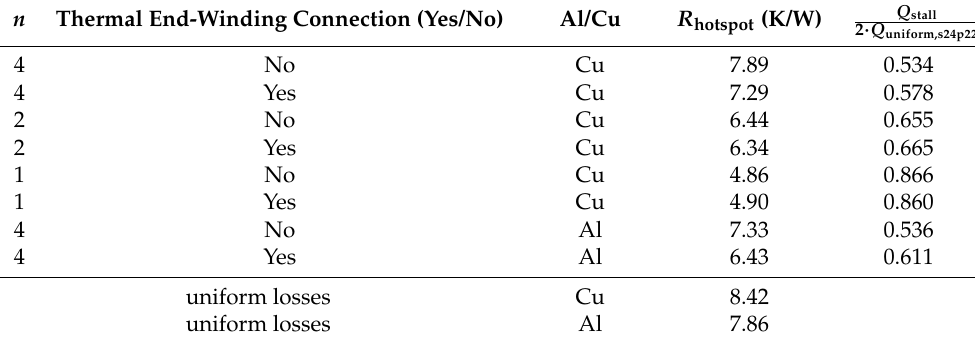
Table 5. Measured thermal resistance between hotspot and housing